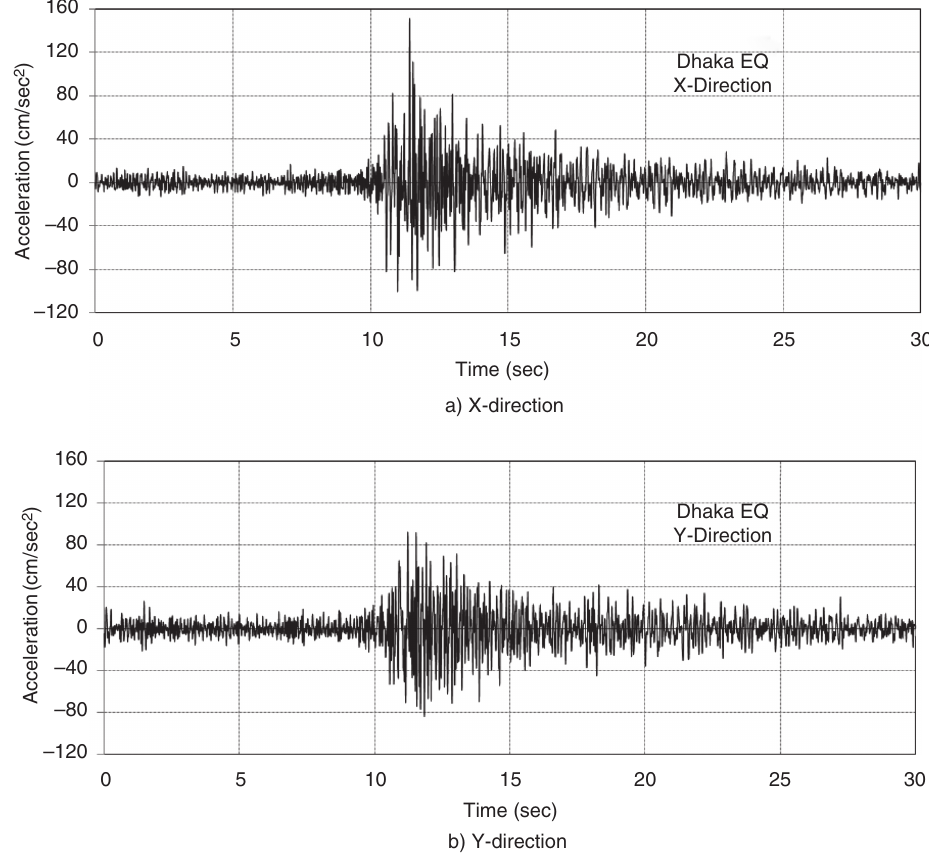
Fig. 5. Dhaka EQ Time History in (a) X-direction and (b)